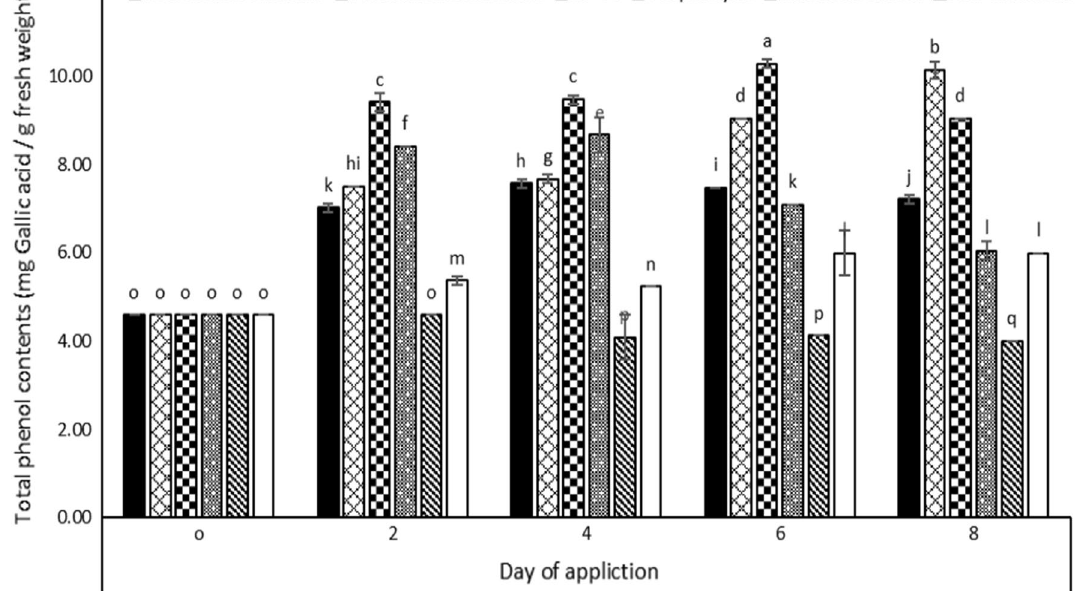
Fig. 1 Effect of Rosemarinus officinalis and Pseudomonas fluorescans on total phenol contents in inoculated potato plants. Values followed by different letters indicate that means are significantly different, while identical letters indicate that means are not significantly different according to Fisher’s least significant difference at p =